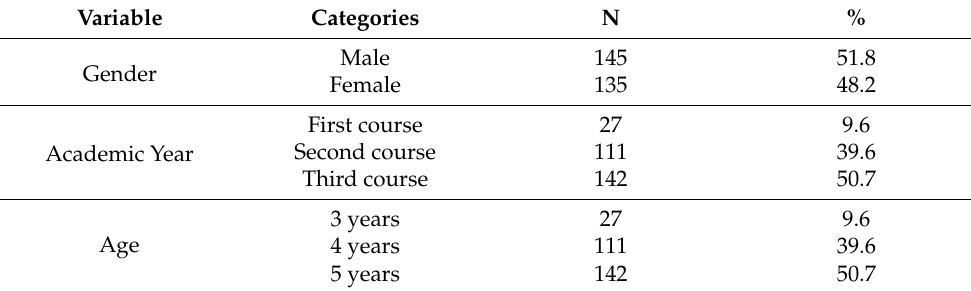
Table 2. Children’s characteristics (N =